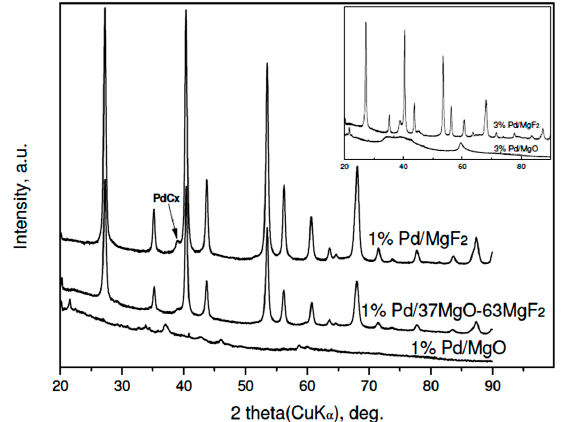
Figure 5. XRD profiles of Pd/MgO-MgF 2 (carbonate) catalysts after CCl 4 hydrodechlorination. Temperature programed hydrogenation of post-reaction deposits presented in Figures 6 and 7